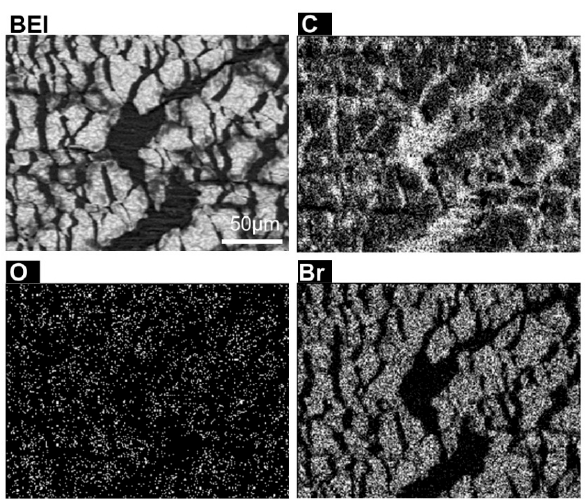
Figure 5. Backscattered electron micrograph and EDX elemental distribution maps obtained from an elongated surface area. The scale bar is in the upper left picture (BEI).